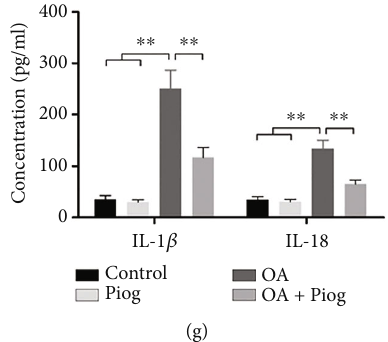
Figure 2: Piog alleviates osteoarthritis and reduces NLRP3-mediated pyroptosis in rat experiments. (a) Gross observation of the control, OA, Piog, and OA + Piog groups. (b) The rat femur coronals were sectioned and stained using S-O staining. The cartilage area is stained red and the subchondral bone blue. The sections of the control, OA, Piog, and OA+ Piog groups were observed under the microscope (bar: 100 μ m). (c – f) Immunohistochemical staining was performed to detect the levels of GSDMD-N and NLRP3 in the lateral femoral condyle of the rat knee (bar: 100 μ m). The immunohistochemical staining results were quanti fi ed. (g) ELISA was used to measure the concentrations of IL-1 β and IL-18 in the cartilage. The data represent three independent experiments and are expressed as mean ± SD. ** P < 0 : 01 . Table 2: OARSI score in each group. Groups OARSI Control 0 : 33 ± 0 : 57